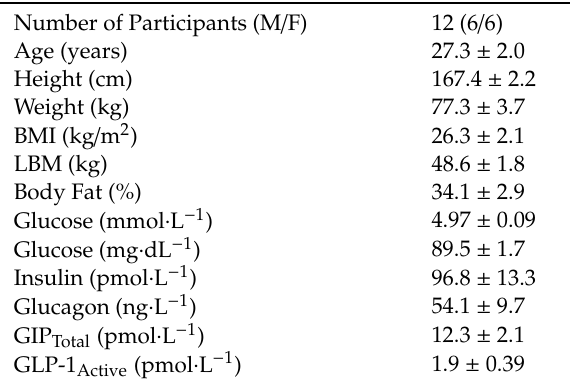
Table 1. Participant